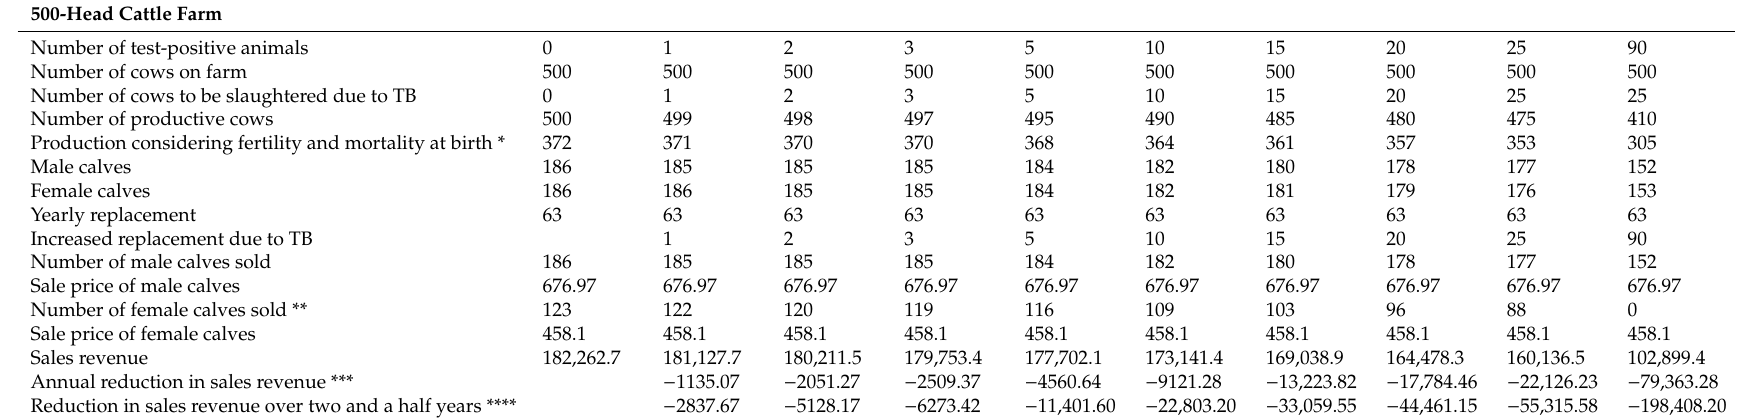
Table 8. Loss from replacement on a farm with 500 head of